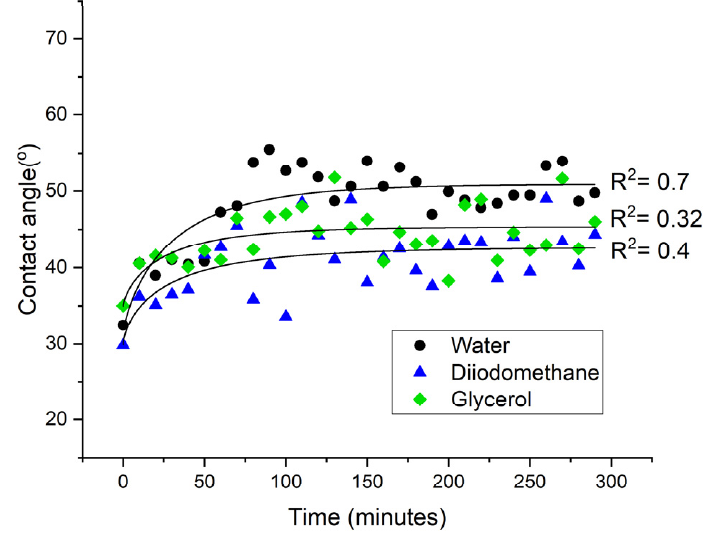
Figure 13. Ageing of GFPA6 surface represented by water, glycerol and diiodomethane contact angles on different locations after µ Plasma modification.